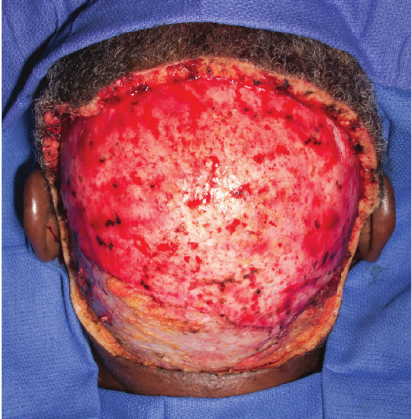
Figure 2: Intraoperative image showing removed diseased scalp to a level just below the galea with preservation of the